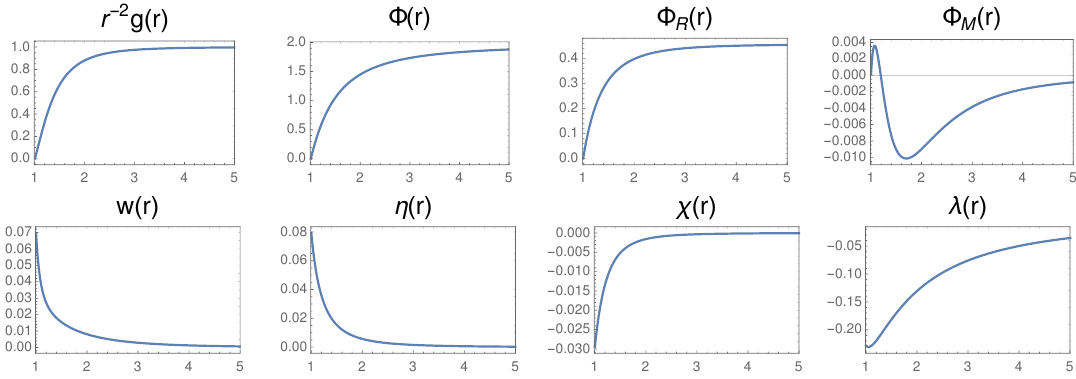
Figure 1 . An example solution, at T=M = 0 : 19 and (cid:22) B =M = 3 : 1. The horizon is at r = r H =